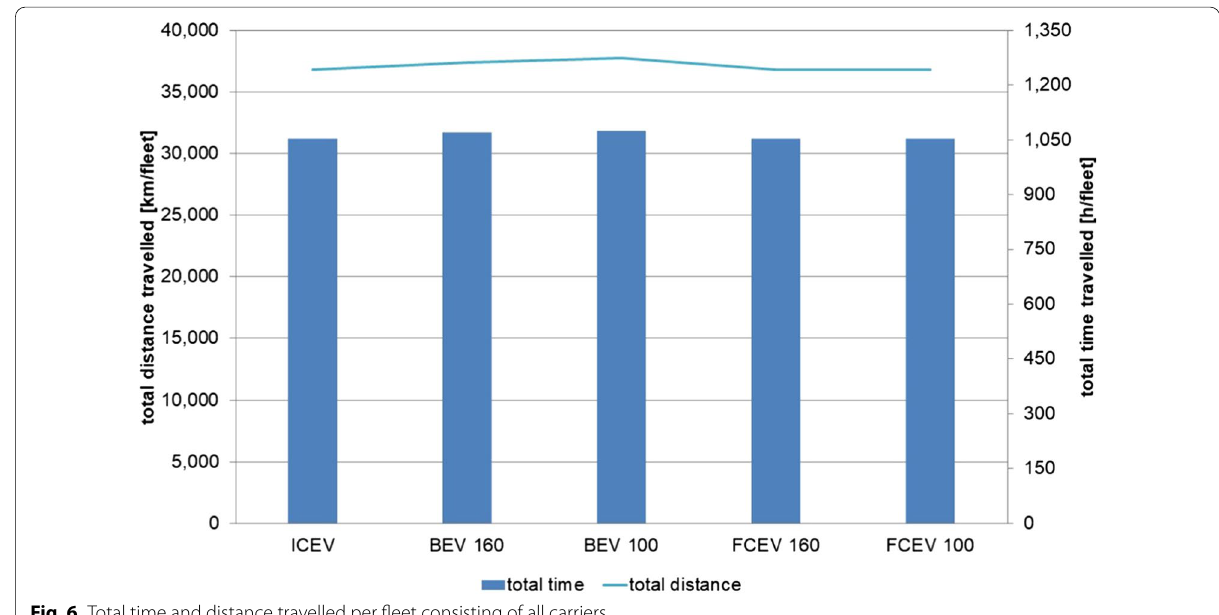
Fig. 6 Total time and distance travelled per fleet consisting of all carriers